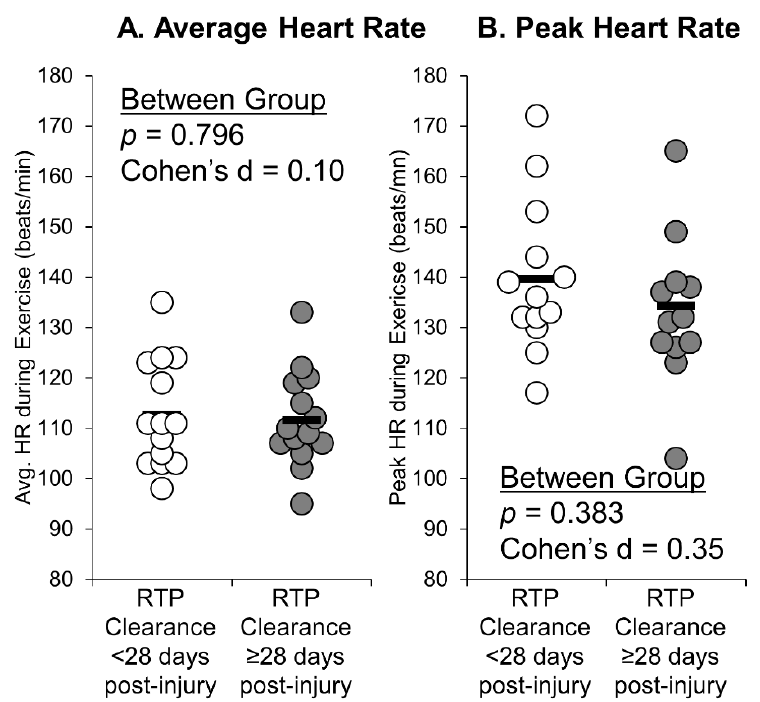
Figure 2. Individual data points describing the average ( A ) and peak ( B ) heart rate during exercise during the two weeks after study enrollment between those who received RTP clearance 28 days or greater post-injury compared to those who received RTP clearance in less than 28 days post-injury. Black bars represent the group mean.